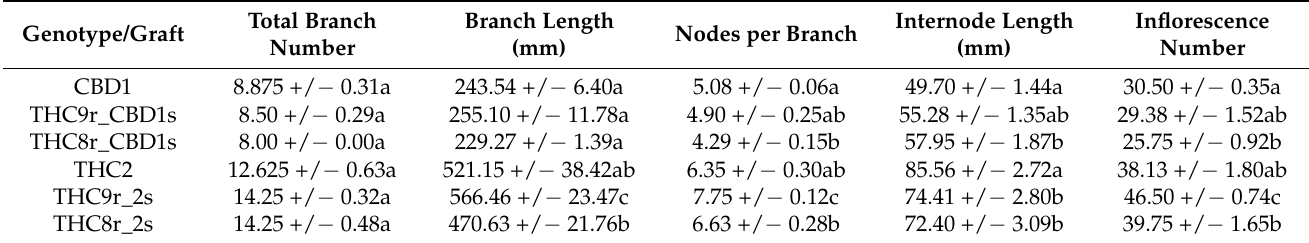
Table 4. Stem morphology of control genotypes and grafted scions. Branch lengths, nodes per branch, and internode lengths are the average values from the 6 branches measured. N = 4, +/ − = SE. Letters after SE denote significant differences between genotypes/grafts (Tukey HSD, p ≤